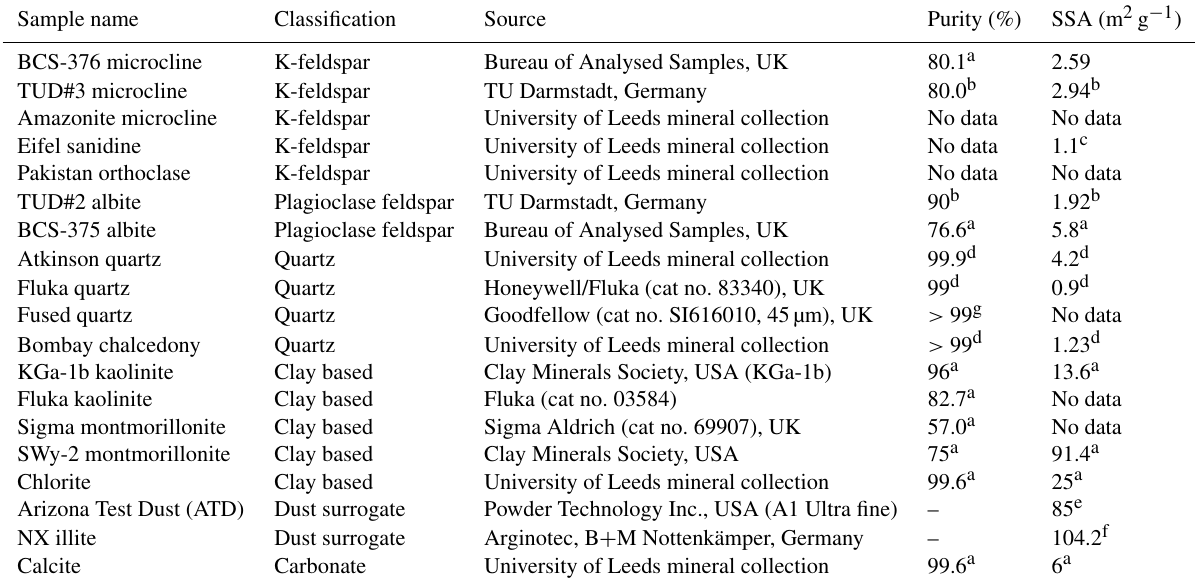
Table 2. Sample information for mineral-based INP samples. Sources of data for purity and specific surface area (SSA) are detailed in the annotations.